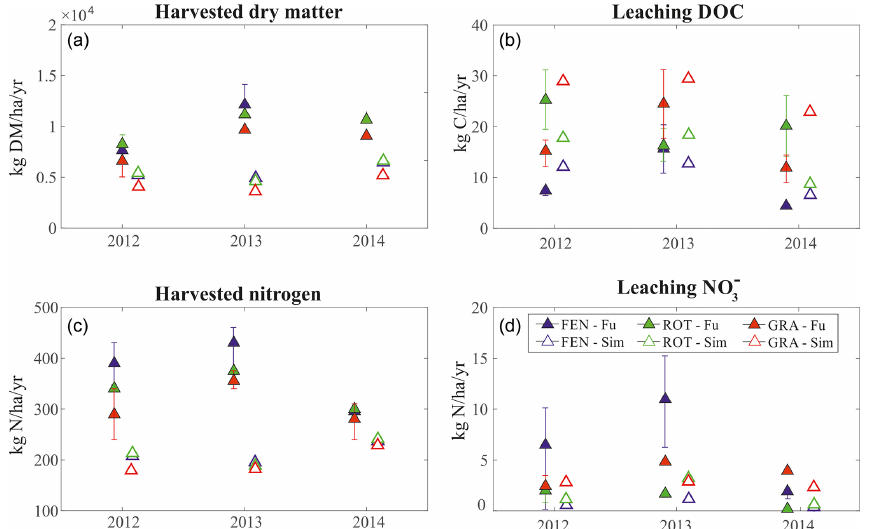
Figure 5. Biogeochemistry module evaluation. Observed versus simulated (a) harvested dry matter, (b) leaching of DOC, (c) harvested nitrogen, and (d) leaching of NO − . Simulated annual totals (empty triangles) are compared with annual totals (full triangles) reported by Fu 3 et al. (2017, 2019) in DE-Fen (blue), DE-RbW (green), and DE-Gwg (red). The uncertainty bars represent the 25th and 75th percentiles of observations.